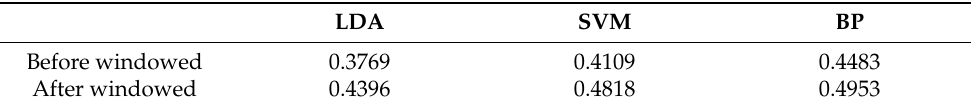
Table 4. Influence of window on the three learning algorithms results. LDA SVM BP Before windowed 0.3769 0.4109 0.4483 After